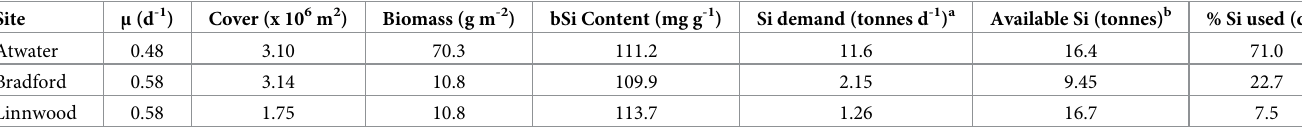
Growth rates ( μ ) were estimated from Cladophora P-content, cover determined using aerial photographs, biomass from measurements of samples collected in situ , and bSi content determined in samples collected from the nearshore. The % Si used (d -1 ) represents the maximum daily Si demand of benthic Cladophora -epiphyte assemblages relative to that available in the overlying water column. a Based on modeled growth rate (from P content), biomass and bSi content b Based on an average dSi of 10 μ M and volume of overlying